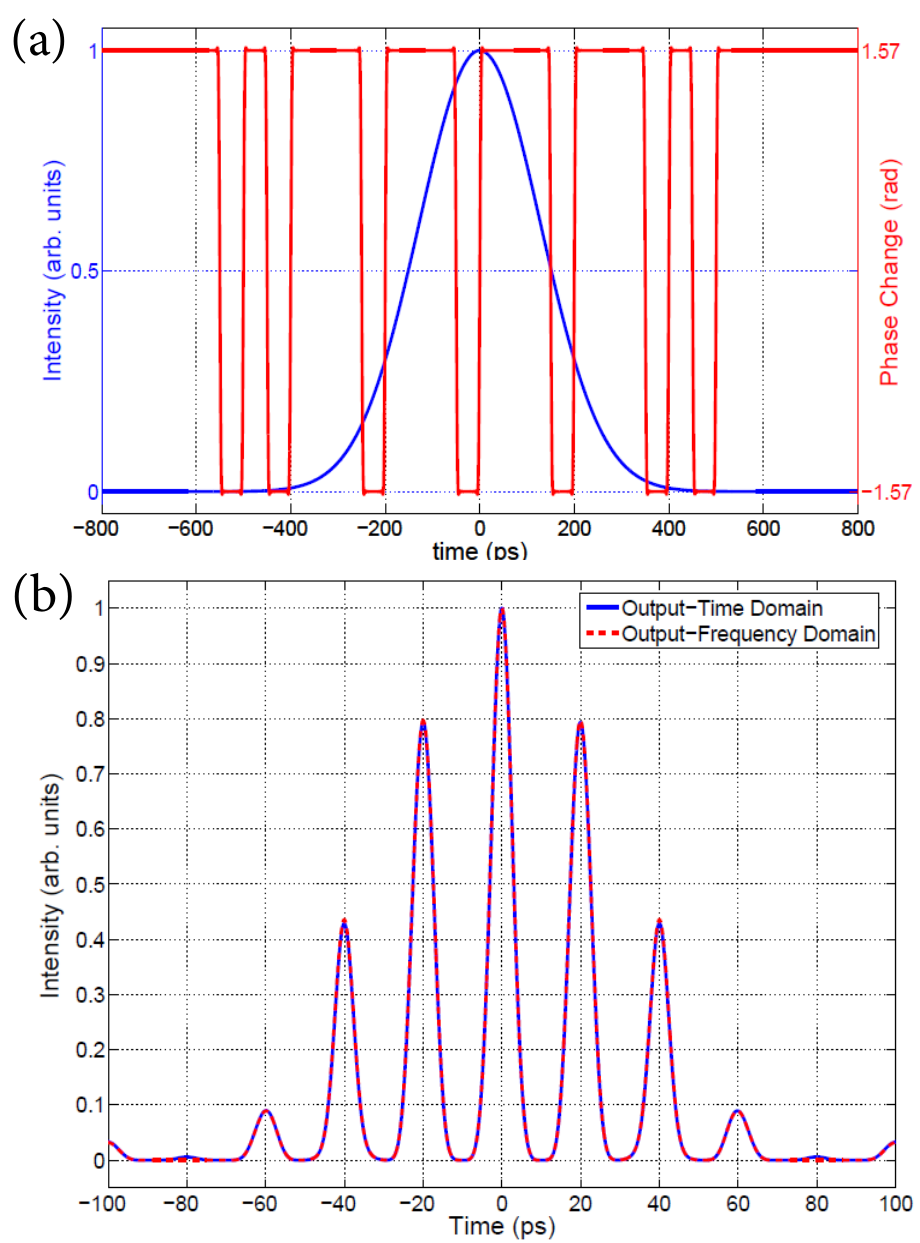
Figure 3. Optical time-domain pulse-shaping. ( a ) Stretched Pulse and imposed phase modulation. ( b ) Output intensity for both time and frequency